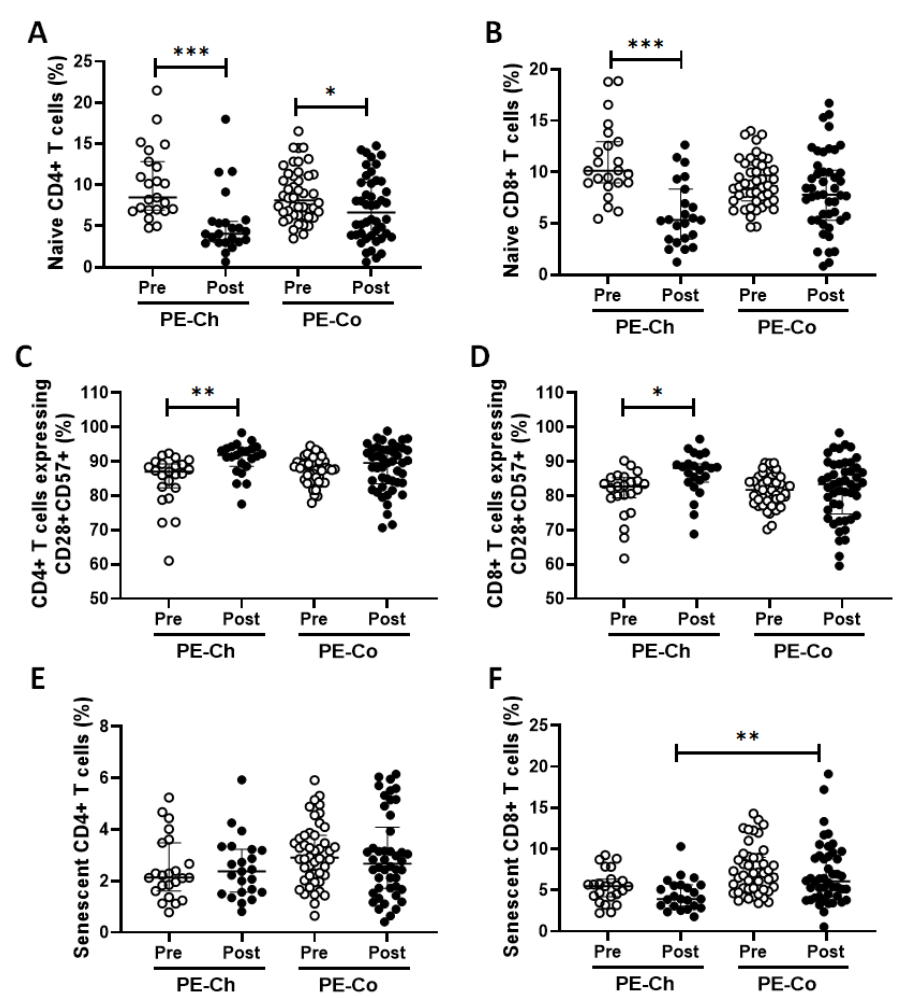
Figure 7. Percentages of naive (CD28+CD57-), double-positive (CD28+CD57+), and senescent (CD28-CD57+) cells, both for CD4+ T cells ( A , C , and E , respectively) and CD8+ T cells ( B , D , and F , respectively) in the older adults of the PE group, both before (pre) and 30 days after (post) the ad- ministration of the second dose of vaccines ChadOx-1 (PE-Ch) or CoronaVac (PE-Co). * p < 0.5; ** p < 0.01; *** p <